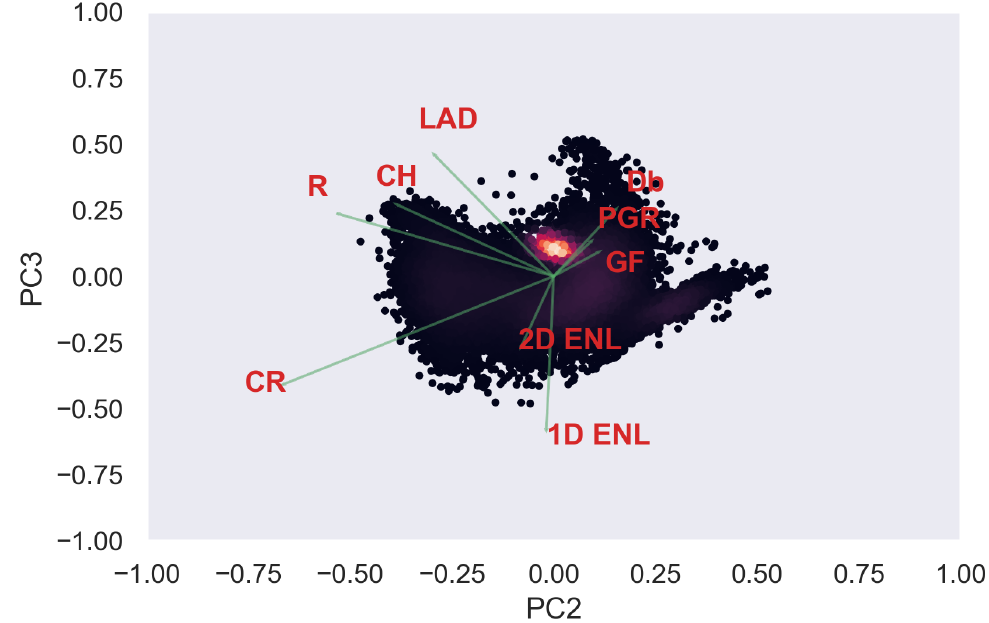
Figure A18. ULS PCA band 2 and 3 loadings at 0.5 m grid size.